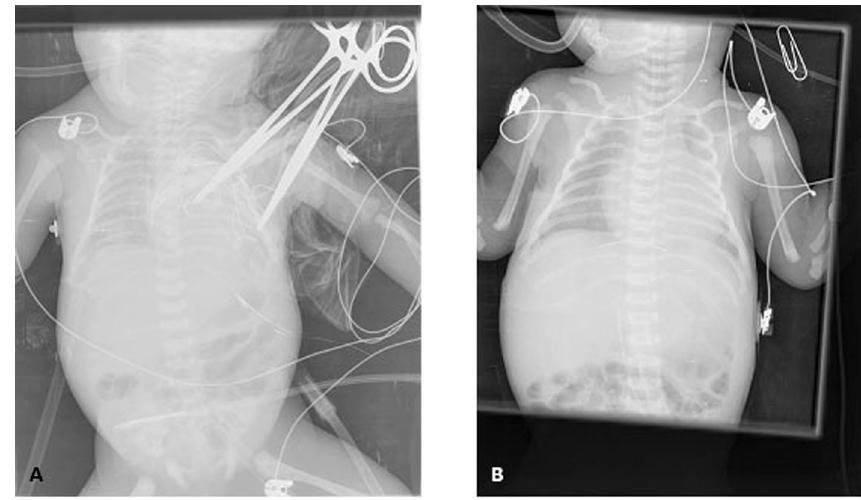
Fig. 2 – A: Anteroposterior chest X-ray (POD1 after ECMO initiation). B: Anteroposterior chest X-ray (POD6 after ECMO